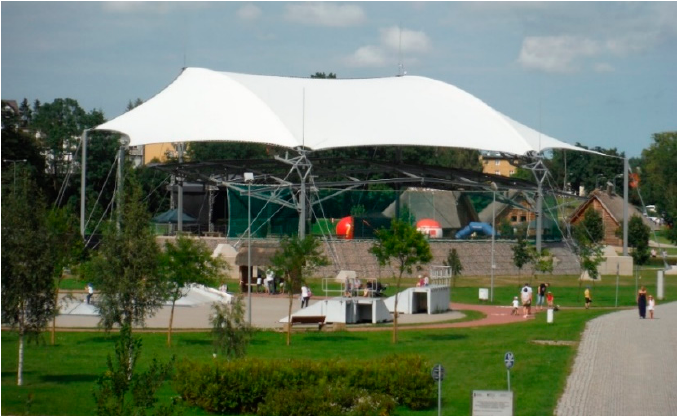
Figure 1. Membrane hanging roof co-designed by the authors in Pruszcz Gdanski, Poland.